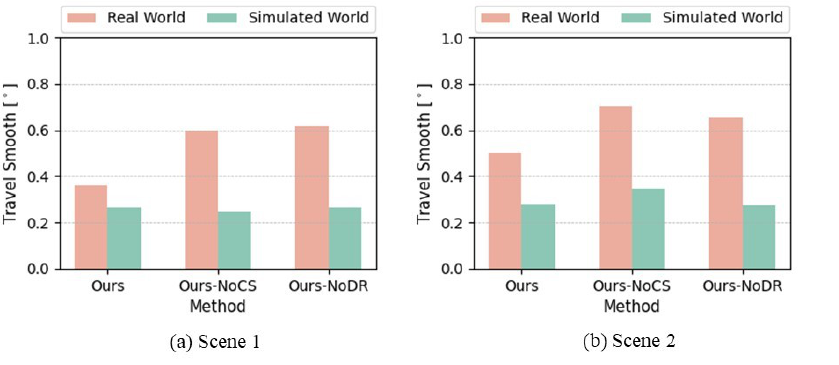
Figure 15. Trajectory